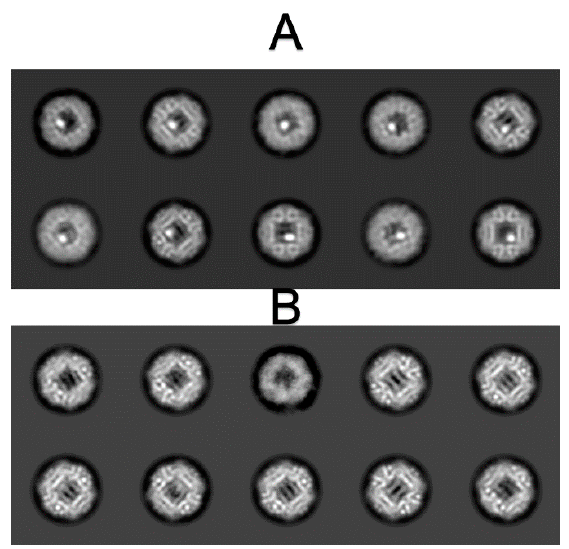
Figure A1. Tow-dimensional classification results of Dps protein with FeSO 4 . ( A )—Dps particles with iron clusters; ( B )—“empty” Dps particles.